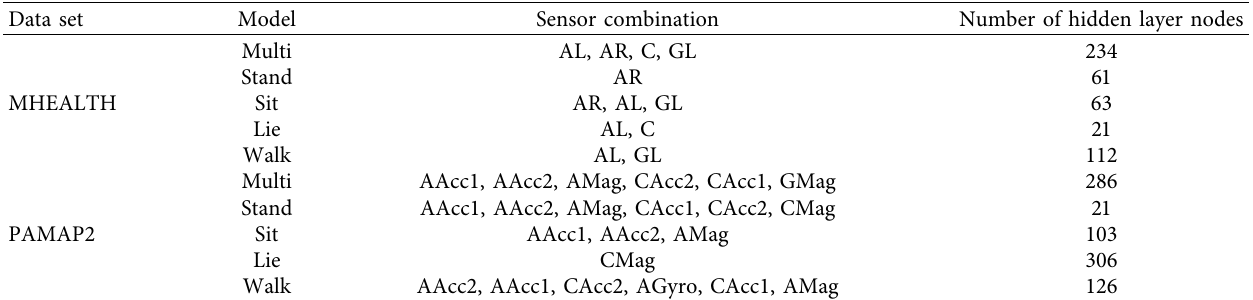
Figure 5: Information gain of multimodal sensors for each classification model in the MHEALTH. (a) Behavior recognition model. (b) Upright monitoring model. (c) Sitting monitoring model. (d) Lying down monitoring model. (e) Walking monitoring model. Table 3: Optimal combination of multimodal